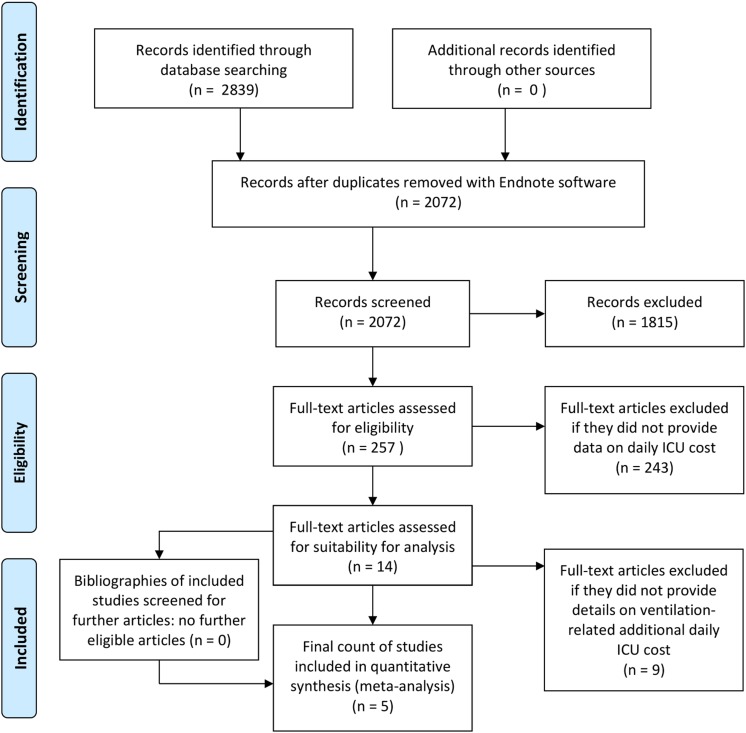
PRISMA flow diagram.